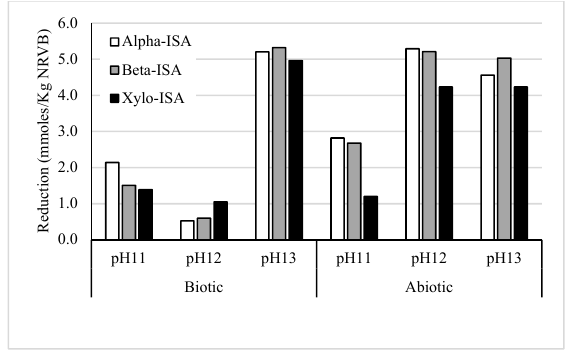
Figure 4. Isosaccharinic acid removal. The removal of isosaccharinic acids in both the biotic and abiotic experiments indicated that both sorption and microbial degradation was occurring, the latter is highlighted by the reduction in pH of the liquid leaving the biotic experiments (Figure